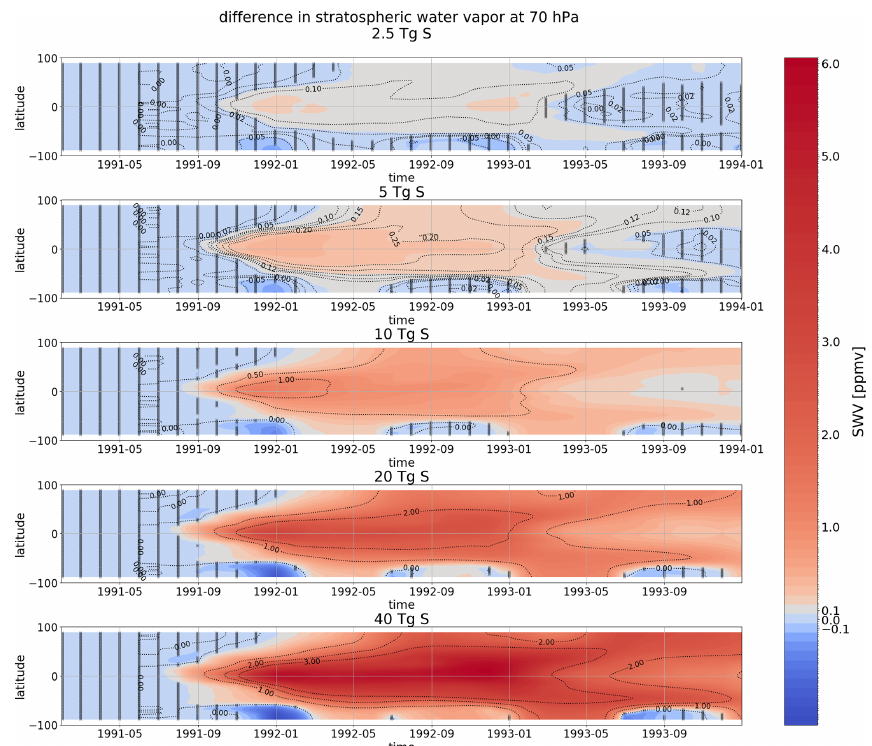
Figure F1. Difference in stratospheric water vapor content at 70hPa as a function of time and latitude. Black crosses mark the regions of statistical significance of the data (Mann–Whitney U test at p = 0 .